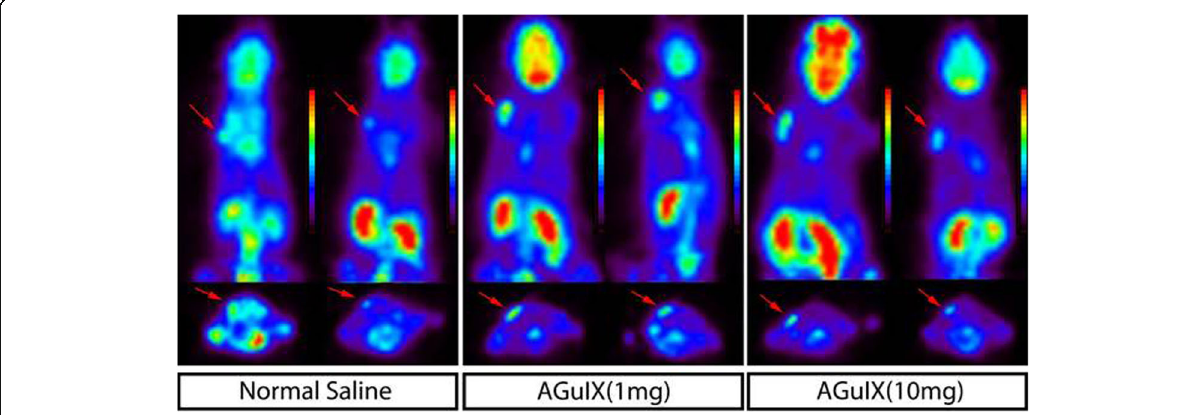
Fig. 4 18 F-FDG PET images of the mice before and after radiation. 18 F-FDG PET images were compared in each panel before (left) and 1 day (right) after irradiation, and the three panels showed the images of mice injected by tail vein injection of normal saline (left panel), 1 mg of AGuIX (middle panel), and 10 mg of AGuIX (right panel), respectively. The same color scale was applied to each of the images